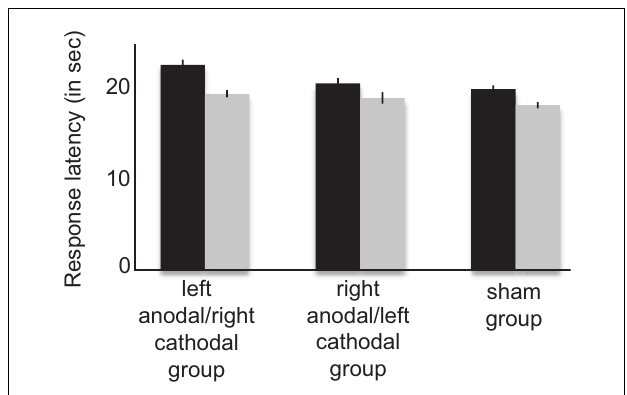
FIGURE 5 |Averaged response latency for each group of participants at the Stroop interference task. Participants were faster when they performed the task the second time as compared as the first time, regardless of their stimulation condition. Error bars represents